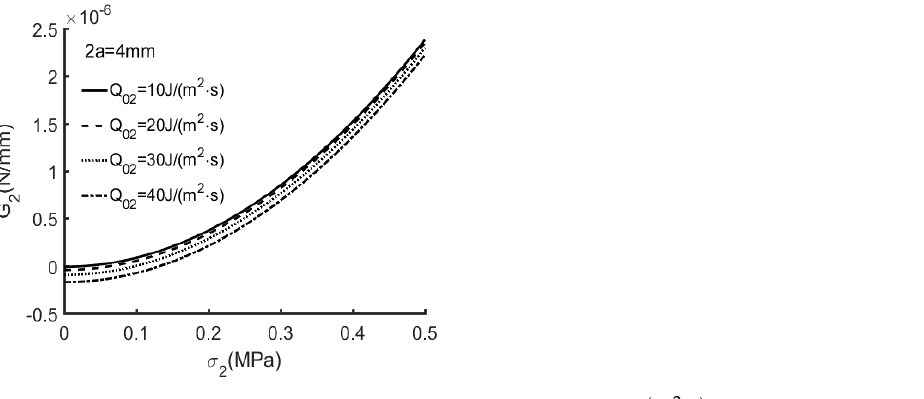
Figure 8. G 2 versus tension stress with Q 02 = 10, 20, 30, 40 J/(m 2 . s) for 𝜛 𝑐 = 0 and 𝜀 = 0.01. (2 a = 4